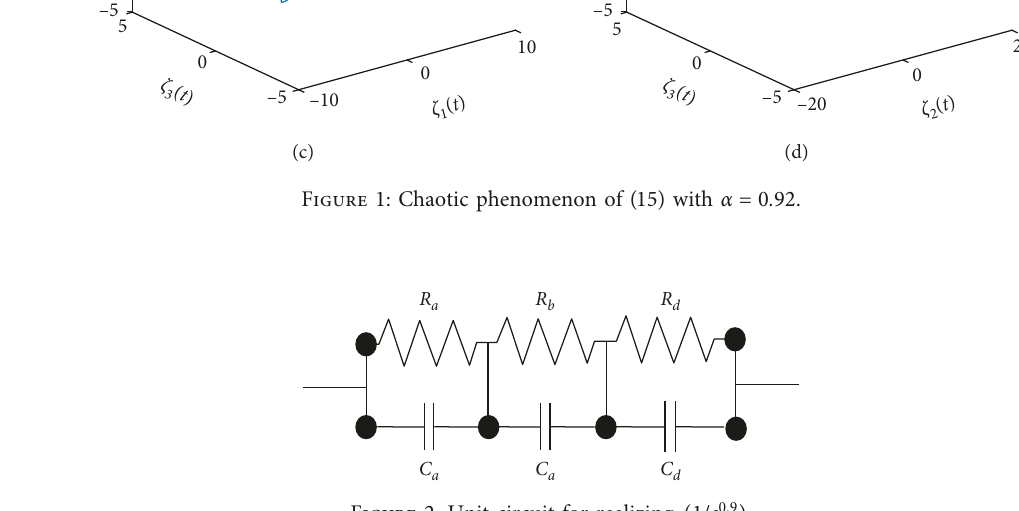
Figure 2: Unit circuit for realizing ( 1/ s 0 . 9 )